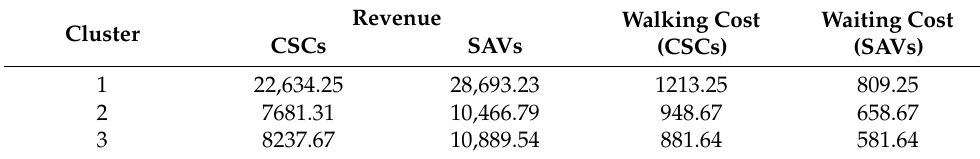
Table 7. Performance of each user cluster (¥).